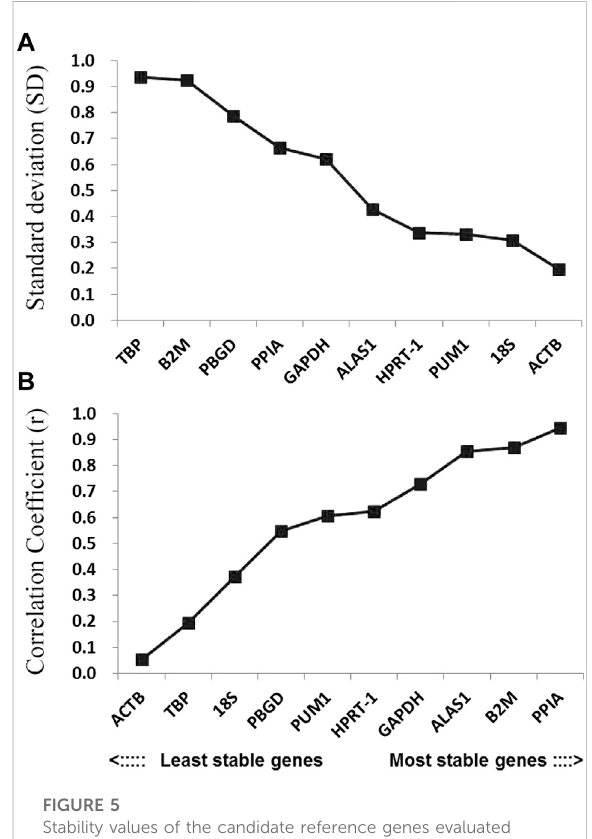
FIGURE 5 Stability values of the candidate reference genes evaluated using BestKeeper software. (A) Standard deviation values of the candidate reference genes; (B) coef fi cient of correlation values of the candidate reference genes.